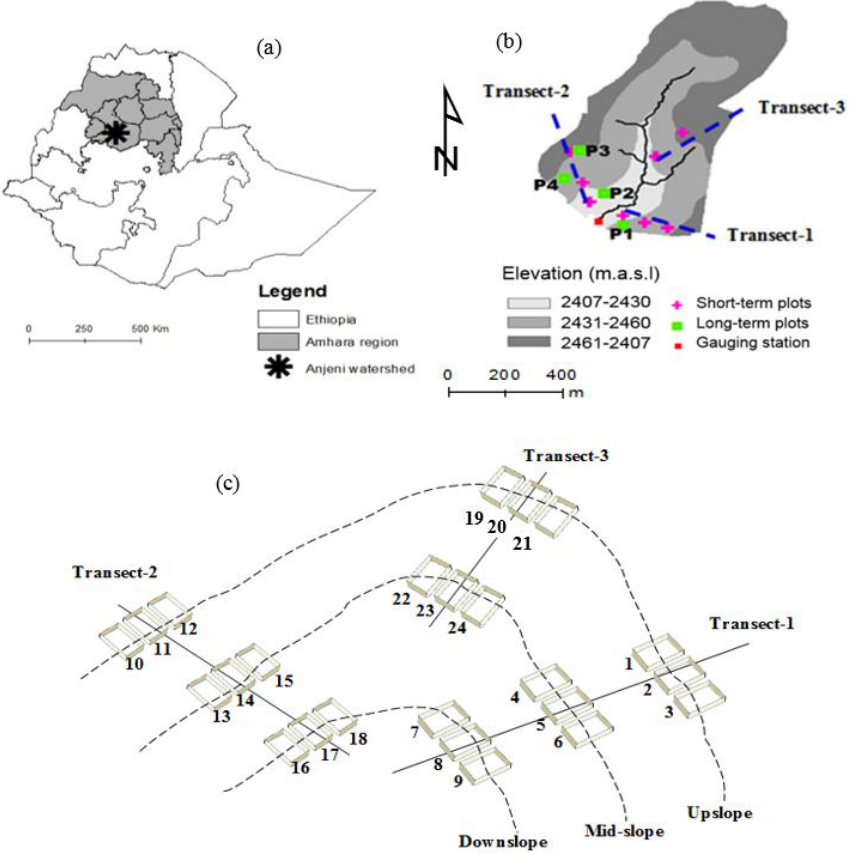
Figure 1. Location of the Anjeni watershed in the Amhara region in Ethiopia (a) , with the location of downslope transects and runoff plots indicated in (b) and (c) (not to scale). Dashed lines in (c) are elevation contours. Three treatments were applied: barley without soil amendment (control) was grown on plots 2, 4, 7, 12, 15, 18, 21, and 23; barley with charcoal amendment was grown on plots 1, 6, 8, 11, 13, 17, 20, and 22; and lupine without soil amendment was grown on plots 3, 5, 9, 10, 14, 16, 19, and 24. Soil and spatial attributes of plots are presented in Table